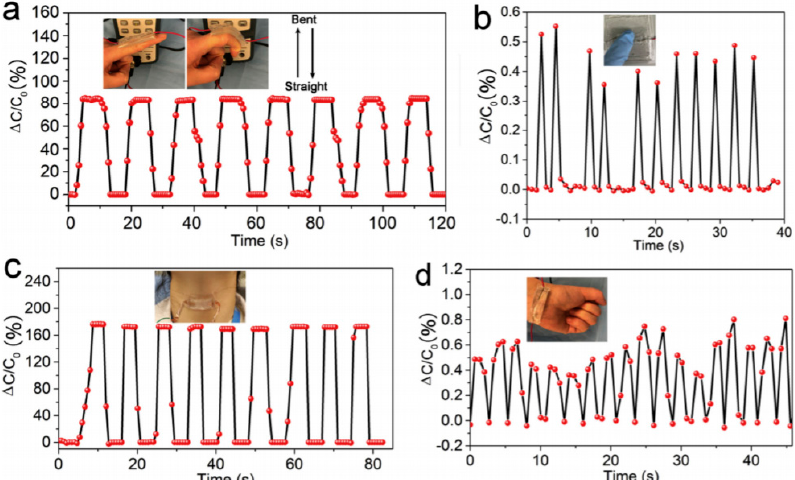
Figure 18. ( a ) Photographs of a hydrogel sensor attached on top of a forefinger and used to detect its motions. ( b ) Response of the hydrogel sensor upon a gentle touch with a finger. ( c ) Real-time capacitance change in the hydrogel sensor attached to the throat to detect deglutition. ( d ) Real-time capacitance signals from the hydrogel sensor when attached to the wrist to measure heartbeat. Reproduced from [76] with permission. Copyright 2019, Elsevier.